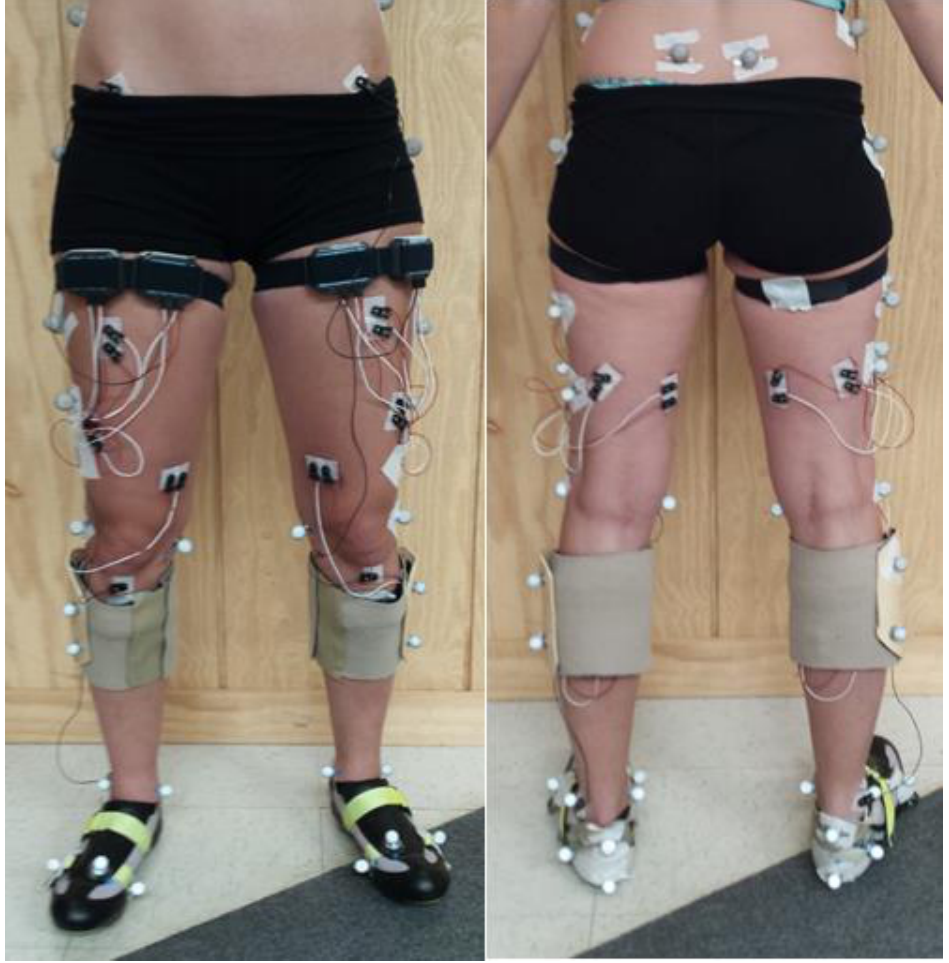
Figure 2. Placement of kinematic markers and electrodes.